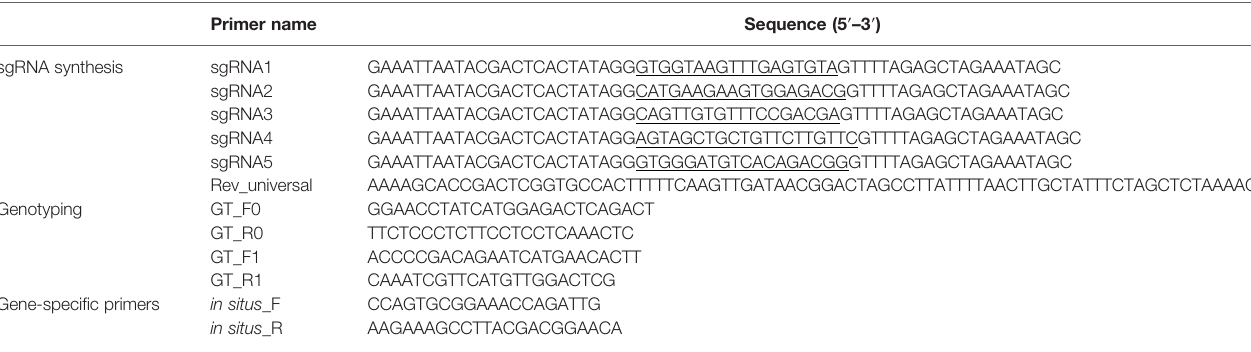
TABLE 1 | sgRNAs and the primers used in this